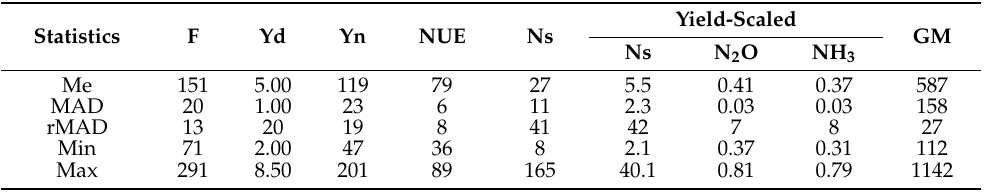
Table 4. Statistics for farm fields where NUE <90% (n = 470); F, Yn, Ns (kg N ha − 1 ); Yd (Mg ha − 1